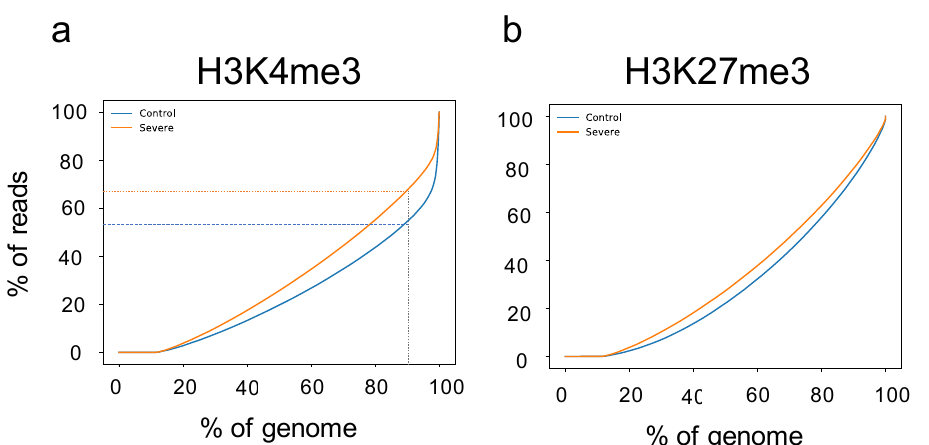
Figure 3. H3K4me3 and H3K27me3 localization at the genome-wide level. Genome-wide normalized histone modification signals split into consecutive non-overlapping bins (10 kb) were retrieved from the group-merged BAM file and ranked on the x-axis. Comparison of H3K4me3 ( a ) and H3K27me3 ( b ) localization signals between control (blue line) and severe AD group (red line). Severe AD group is characterized by a greater spread in the H3K4me3 signal, while no differences between groups are present in H3K27me3 profiles.